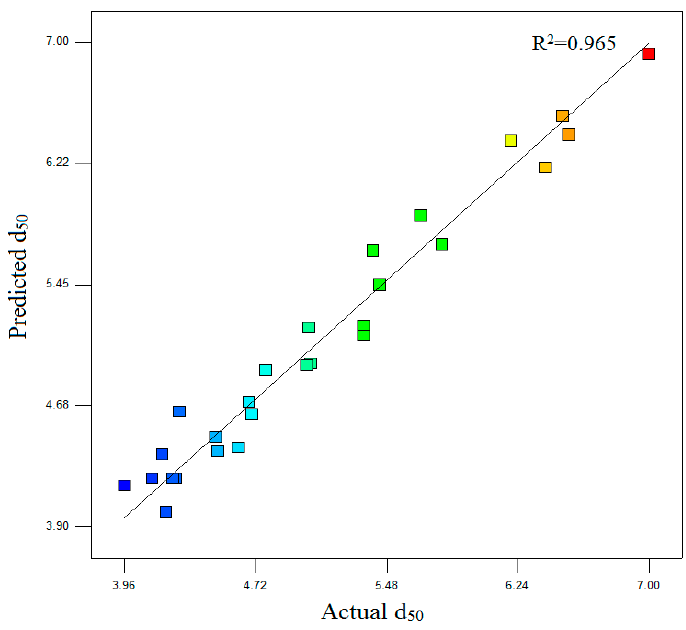
Figure 3. Relationship between actual and predicted d 50 values.